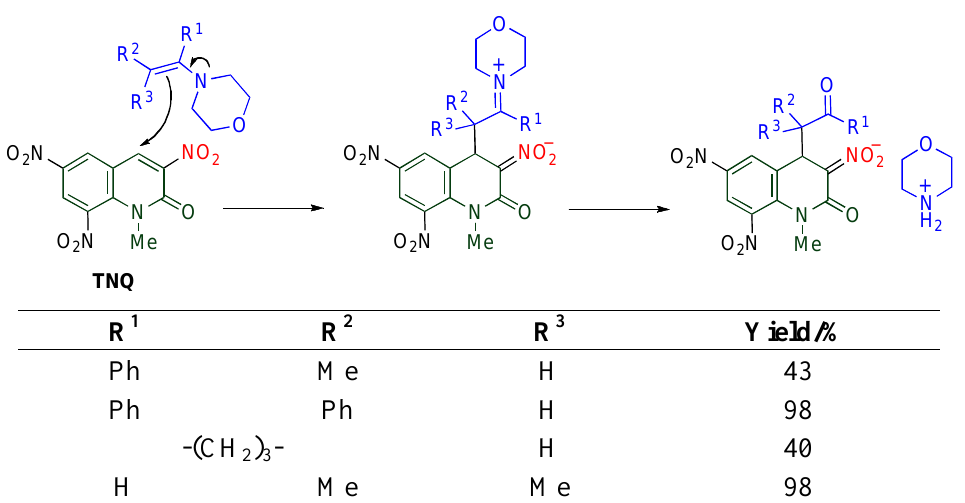
Table 10. Reaction of TNQ with